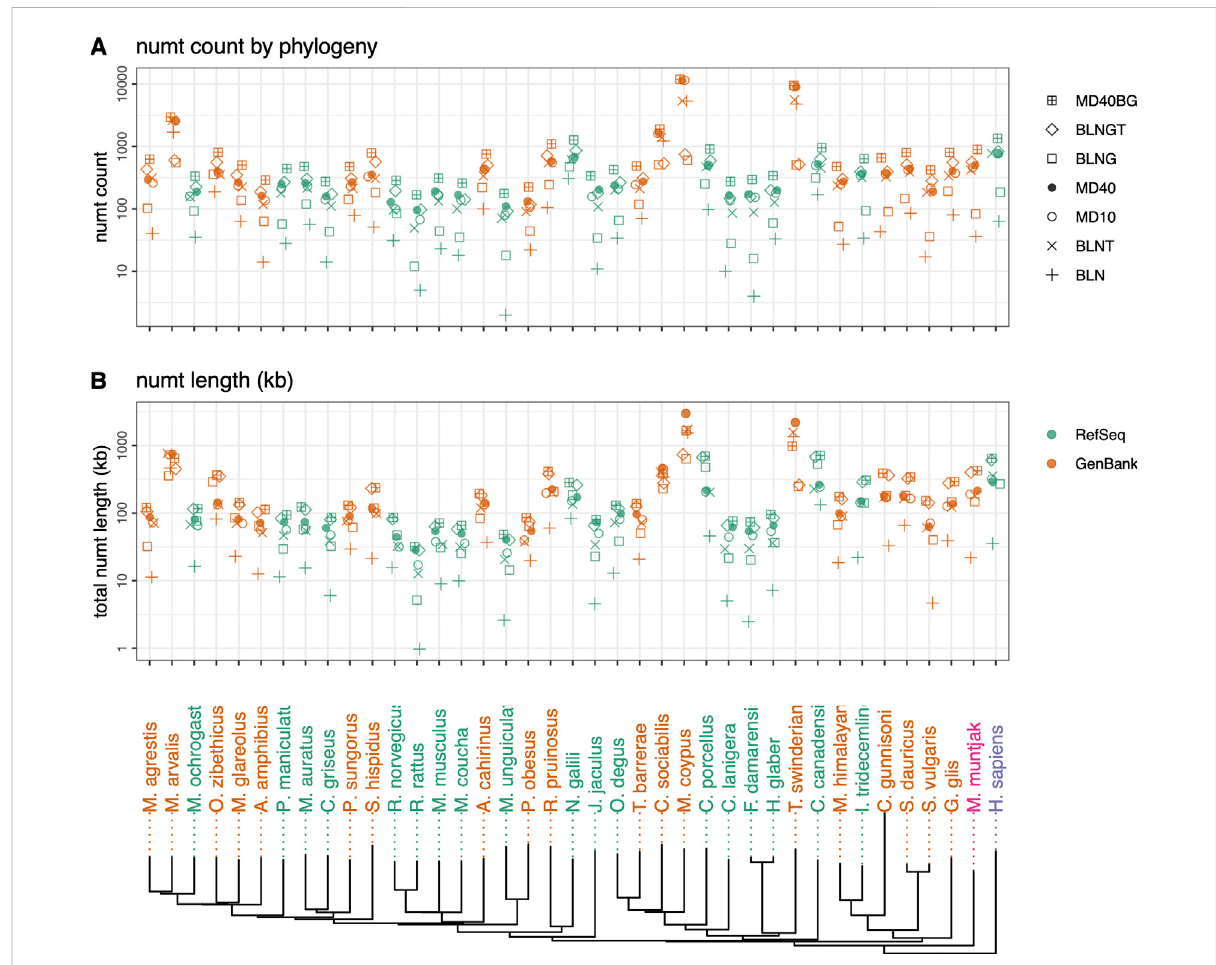
FIGURE 1 Rodent neighbor-joining tree constructed with full mtDNA genome sequences with M. muntjak colored in pink and H. sapiens colored in purple. GenBank genomesare colored orange andRefSeq colored green. Thethree volespecies fromthegenus Microtus ( M.agrestis,M.arvalis and M.ochrogaster )arefoundonthefarleft.Totalnumtcounts (A) andlength (B) areshownforeachspeciesforthe7differentsimilaritysearchesrunare shown as follows: 1) plus sign (+): coding sequence queries — BLASTN DNA:DNA with “ -task megablast ” default option (BLN); 2) (x): coding sequence queries — BLASTN DNA:DNA with “ -task blastn ” option (BLNT); 3) open circle: coding sequence queries — TFASTX protein:translated-DNA searches with the MD10 protein scoring matrix (MD10); 4) fi lled circle: coding sequence queries — TFASTX protein:translated-DNA searches with the MD40 protein scoring matrix (MD40); 5) open square: whole mtDNA genome queries — BLASTN DNA:DNA with “ -task megablast ” default (BLNG); 6) diamond: whole mtDNA genome queries — BLASTN DNA:DNA with “ -task blastn ” option (BLNGT); 7) square with plusinside: combined